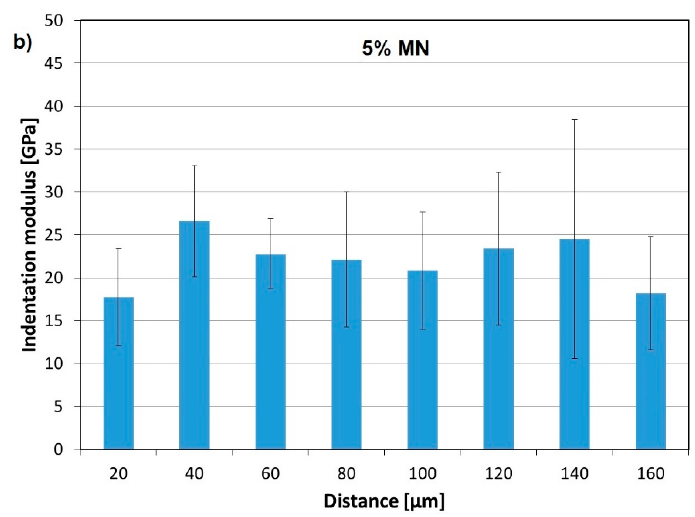
Figure 16. The results of measurements of the indentation modulus of the tested specimens in the transition zone: ( a ) reference sample (0% nano-Fe 3 O 4 /SiO 2 ) and ( b ) 5% nano-Fe 3 O 4 /SiO 2 content (Reprinted with permission from [83]. Copyright 2017 Elsevier).